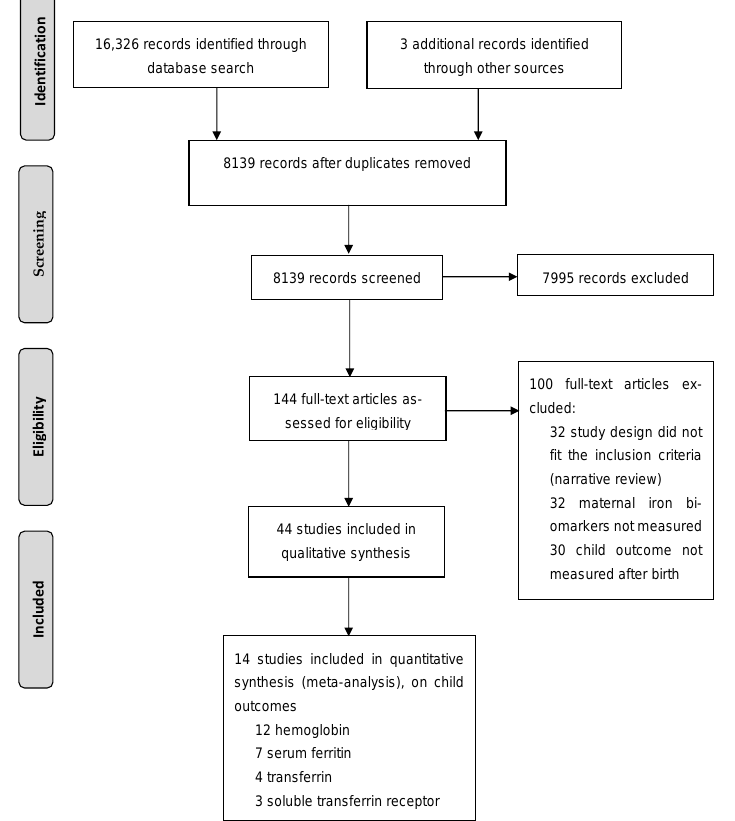
Figure 1. PRISMA flow diagram.